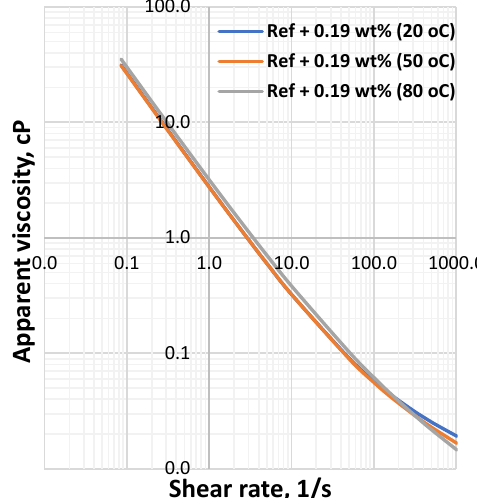
Figure 7. MoS 2 blended drilling fluid—0.09 wt.%.